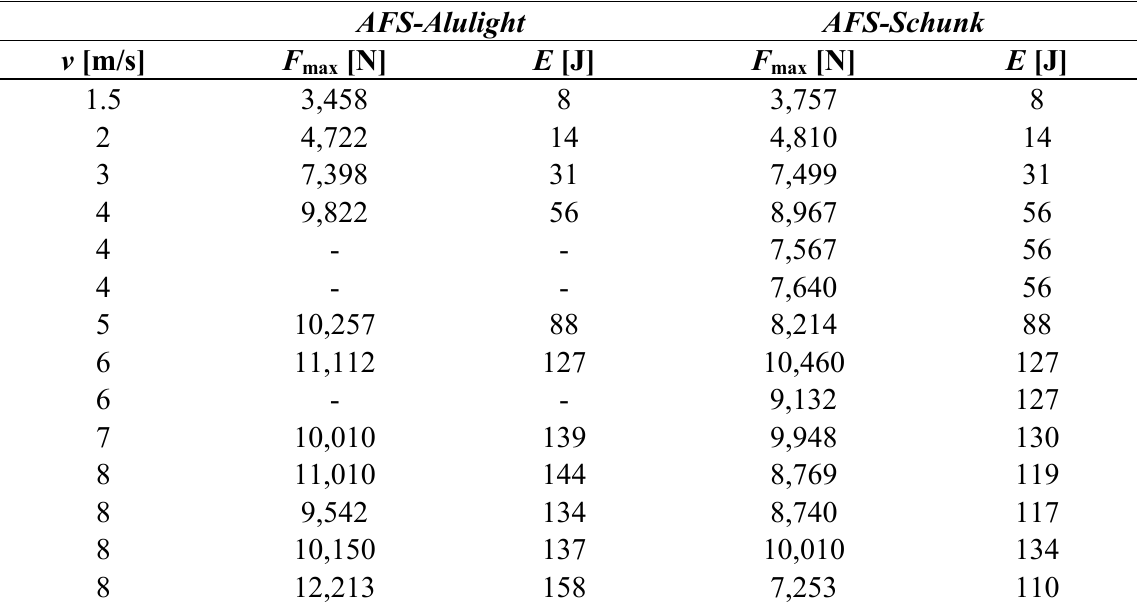
Table 3. Results of all the impact